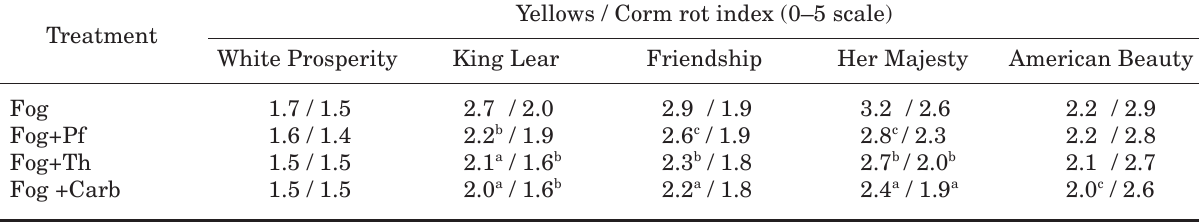
Table 1. Effect of application of Fusarium oxysporum f. sp. gladioli (Fog) , Pseudomonas fluorescens (Pf), Trichoder-